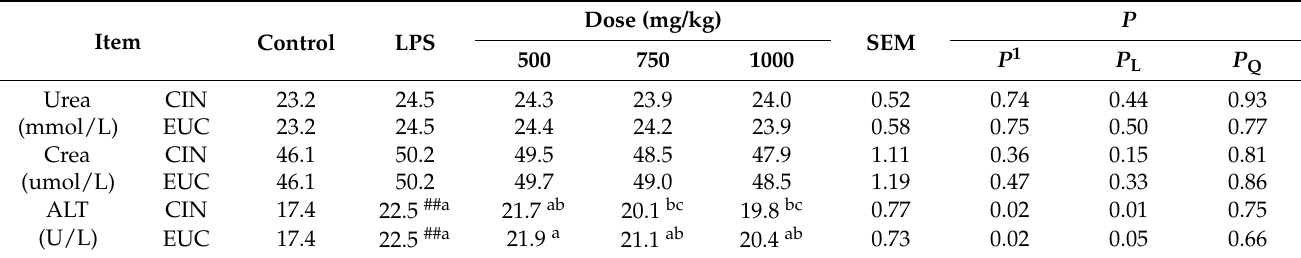
Table 3. Effects of EOs on serum metabolic indexes of mice induced by LPS.